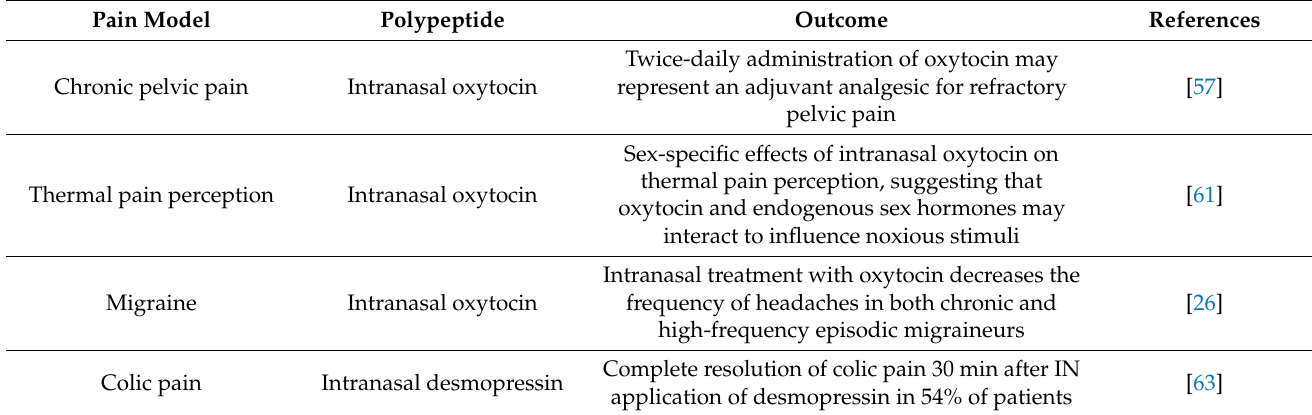
Table 2. Summary of clinical trials using intranasal polypeptides for